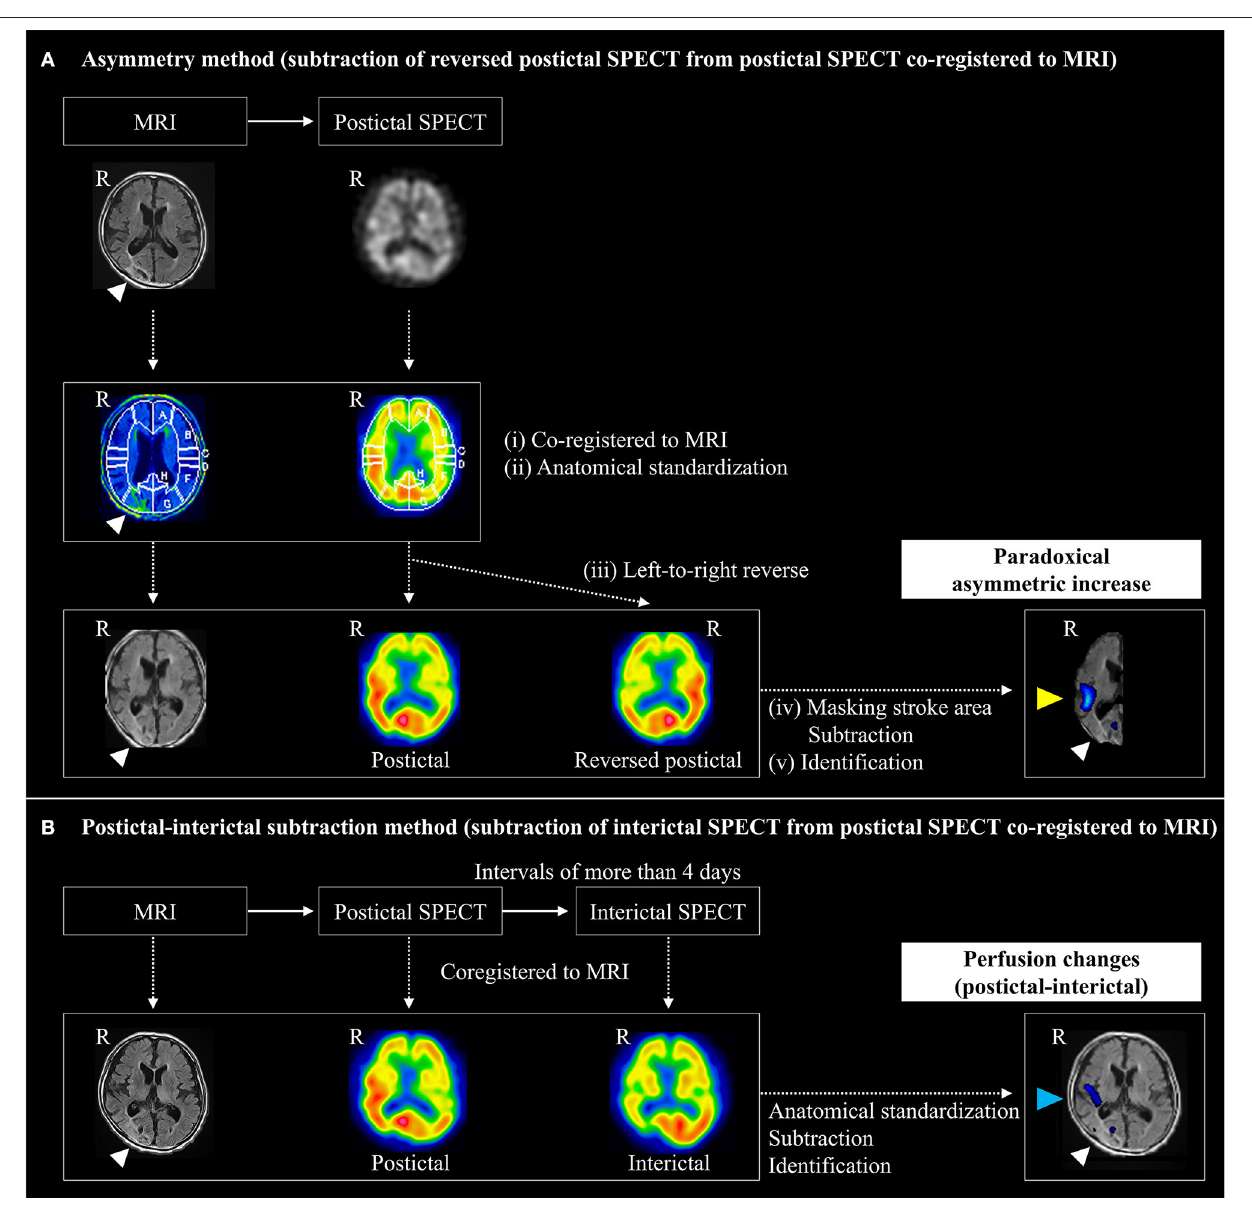
FIGURE 2 | Imaging analysis protocol for detecting prolonged postictal hyperperfusion. Postictal hyperperfusion was evaluated by the following two methods: (A) the asymmetry method and (B) the postictal-subtraction method. (A) The asymmetry method was devised for detecting a higher perfusion area (yellow arrowhead) in the hemisphere ipsilateral and adjacent to stroke lesions (white arrowhead), compared to the corresponding contralateral area, which was defined as a paradoxical asymmetric increase by subtracting anatomically standardized non-reversed SPECT imager from left-to-right reversed postictal SPECT images to obtain non-reversed – reversed difference. (B) The postictal-interictal method was devised based on detecting an area of perfusion postictal-interictal changes (arrowed in blue): anatomical standardized postictal and interictal SPECT images were subtracted to obtain the postictal – interictal difference. R,